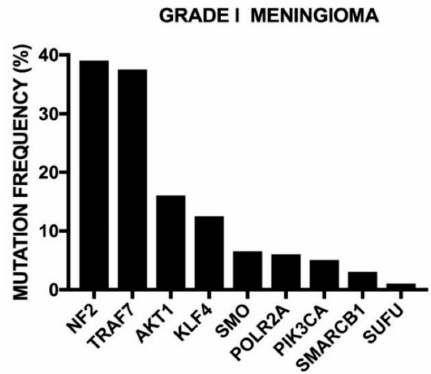
Figure 10. Recurrent gene mutations observed in grade I meningiomas. Data are reported by Clark et al.